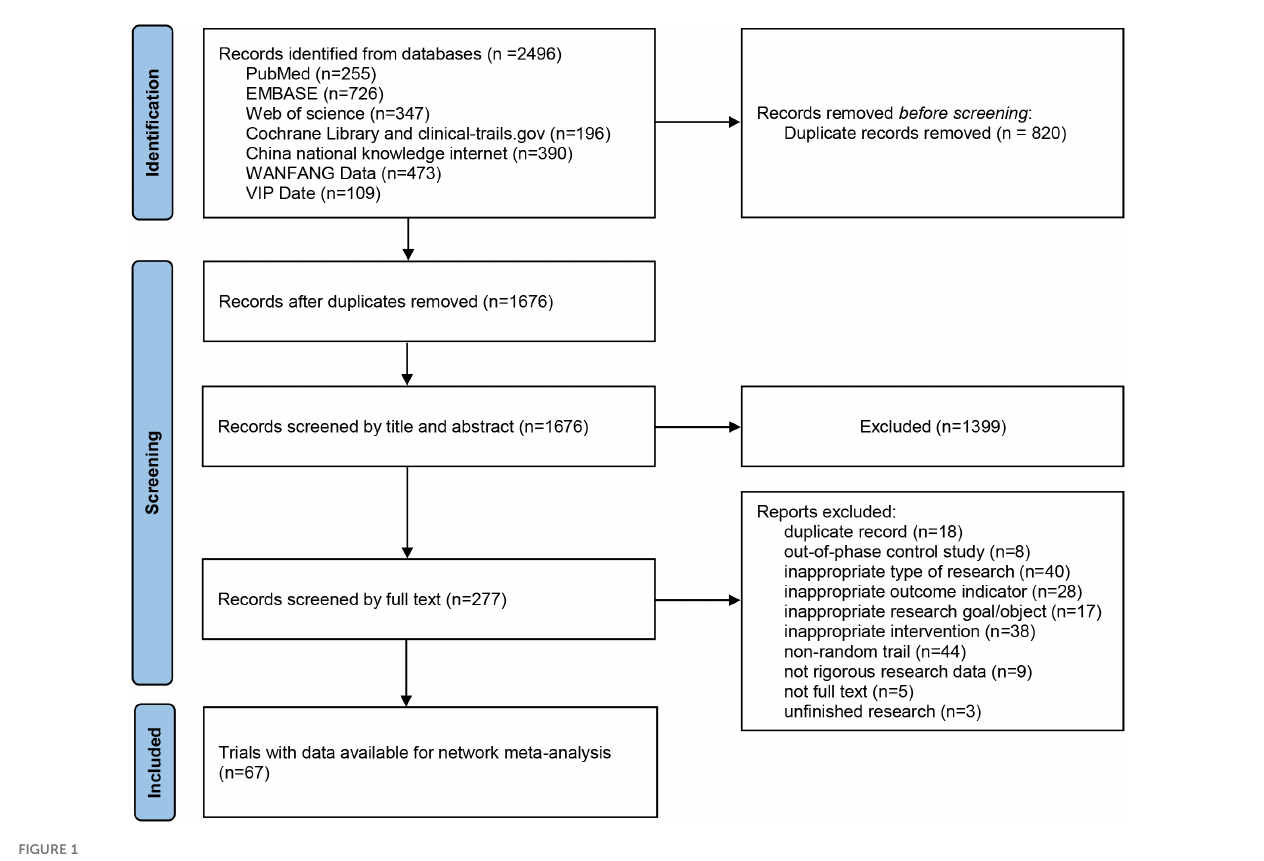
FIGURE 1 Study selection